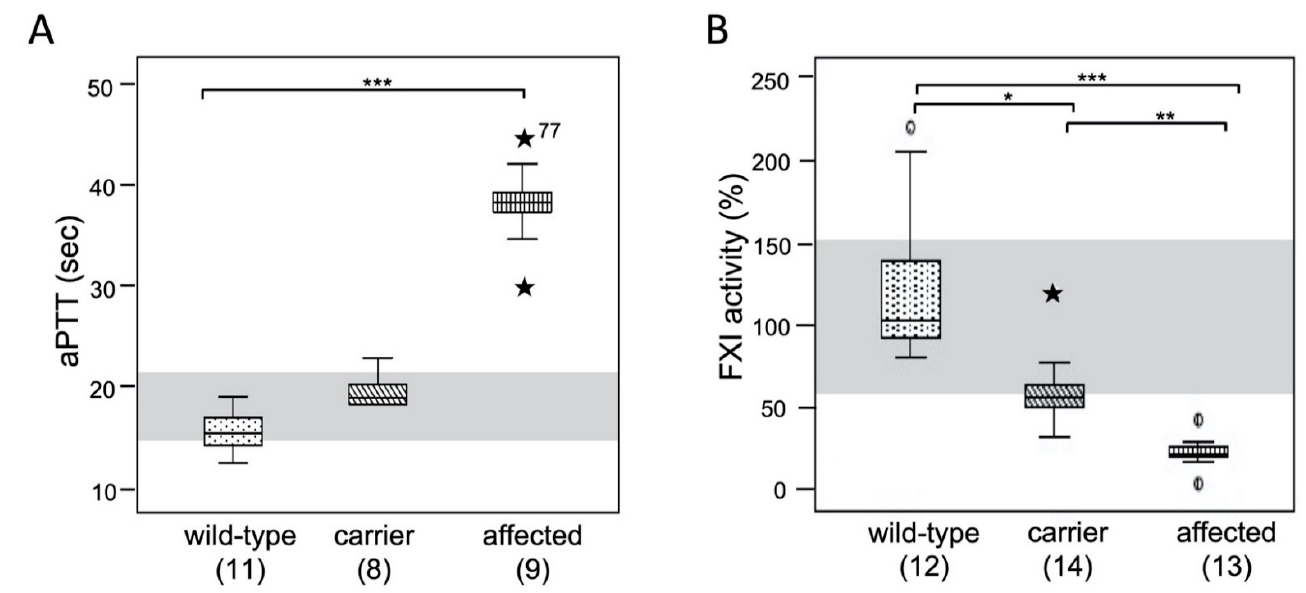
Figure 3. Coagulation test results. ( A ) Activated thromboplastin time and ( B ) plasma FXI activity, for MCCs of the core family based on genotyping results. The median, 95% confidence interval and range with outliers ( (cid:70) ) are shown. The light grey horizontal bar indicates the aPTT (15.0–21.0 sec.) and FXI activity reference intervals (60–150%). *, p < 0.05; **, p < 0.01; ***, p < 0.001.